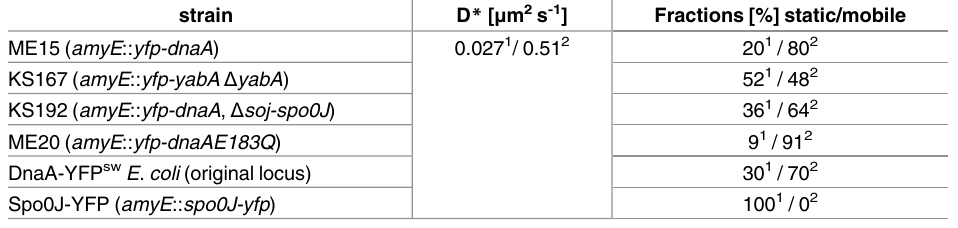
Table 4. Determination of mobile and static fractions(simultaneous fit over all step size